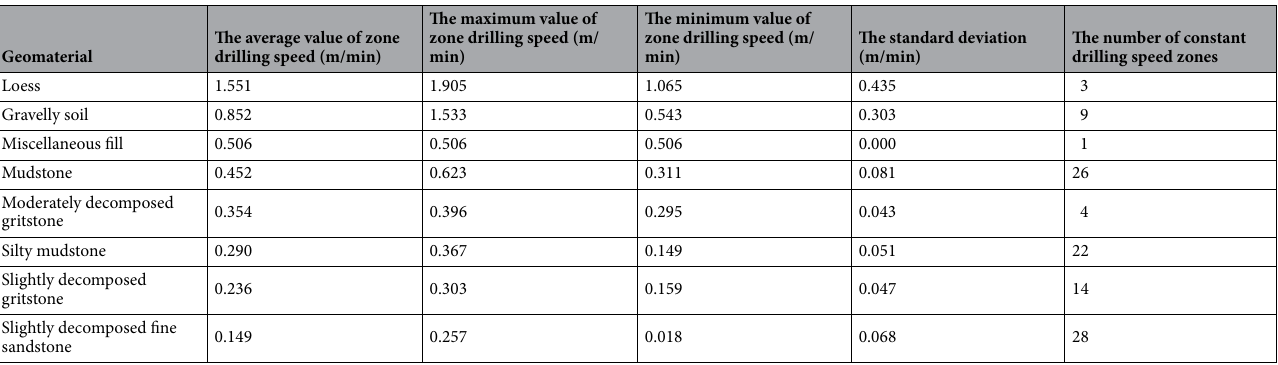
Table 1. The zone drilling speed and zone thickness by digitalization results for eight strata.